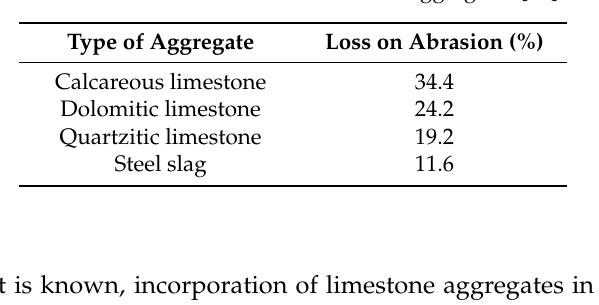
Table 3. Loss on abrasion in the coarse aggregates